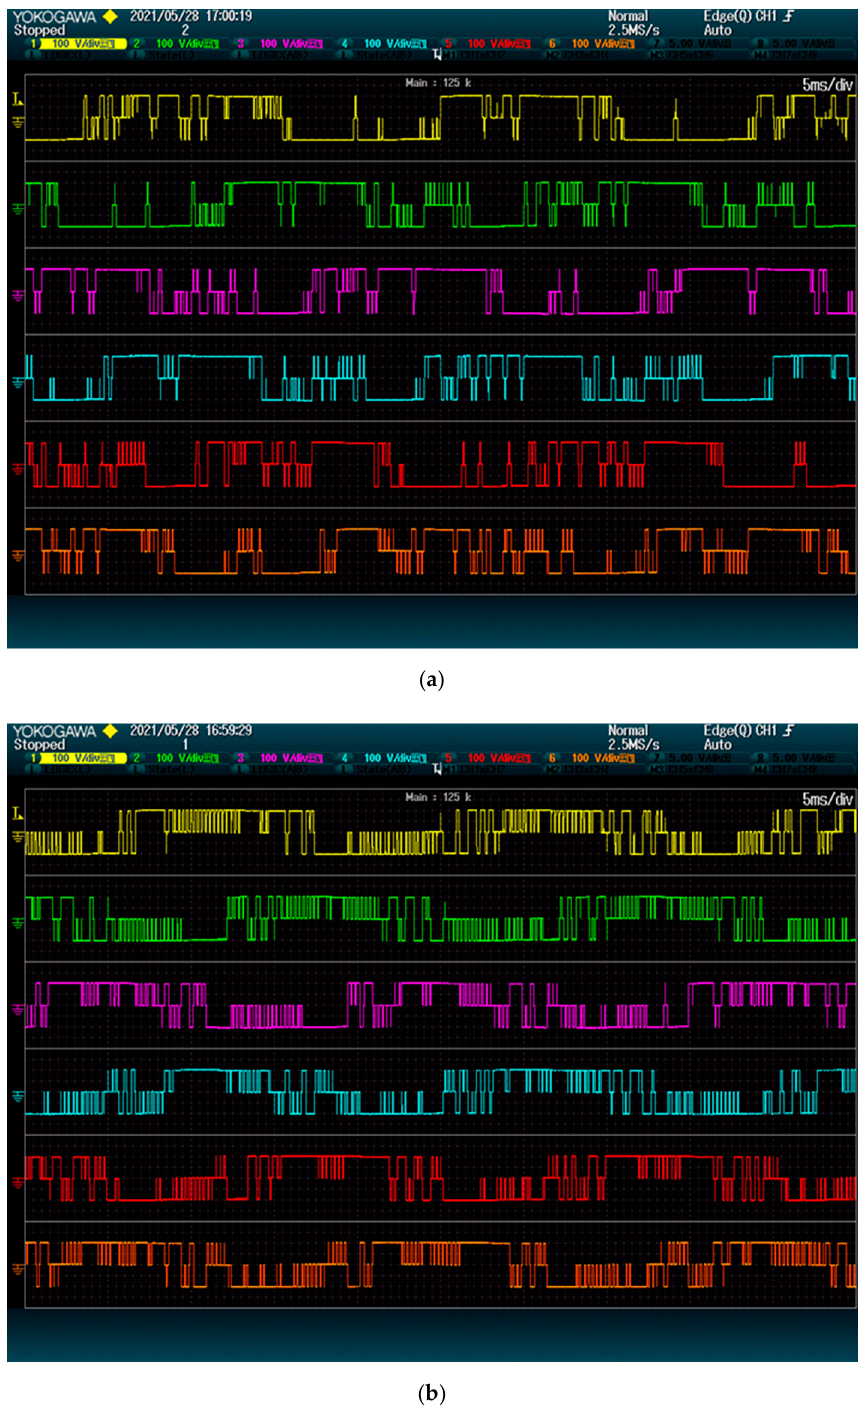
Figure 6. Modules output: ( a ) proposed method; ( b ) state-of-the-art alternative. The plots show 2.5 grid periods.